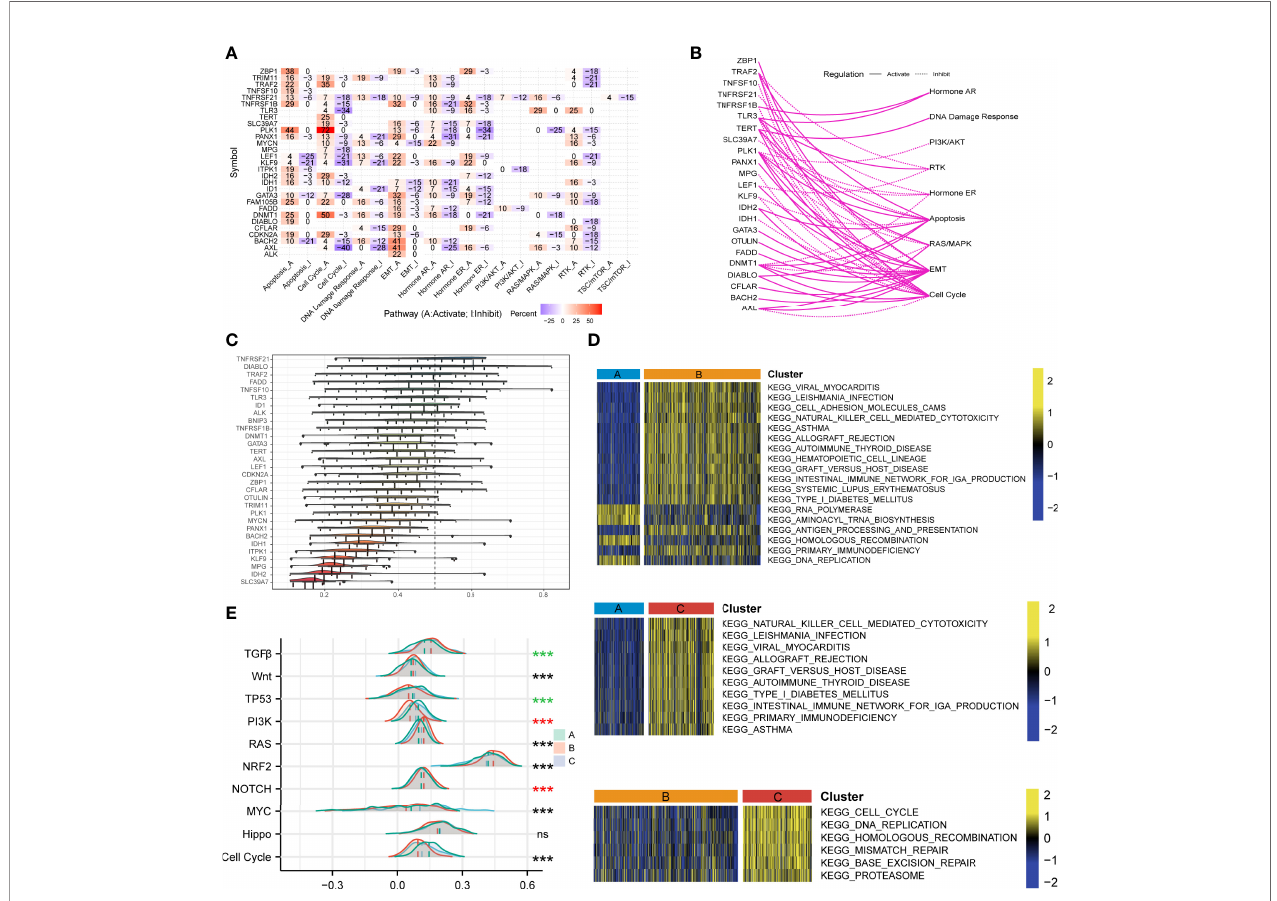
FIGURE 5 | Investigations of necroptosis- and cancer-related signaling pathways. (A) The heatmap illustrated the correlations between the mRNA expressions of the 29 necroptosis molecules in universally recognized cancer-related signaling pathways. Only a function (inhibited or activated) in at least 5 cancer types was displayed. “ Pathway activate ” in red represented the percentage of cancers where a pathway might be activated by the necroptosis regulators, and inhibition in a similar way illustrated as “ Pathway inhibit ” in blue. (B) The network showed the relationship between necroptosis regulatory genes by a line connection. The solid line meant activation, while dashed lines meant inhibition. (C) The distributions of functional similarities of the necroptosis-related molecules were summarized as complex boxplots. The boxes represent the middle 50% of the similarities, and the upper and bottom boundaries showed the 75th and 25th percentile. The lines in the boxes indicated the median values of the functional similarities. The continuous distribution was shown as the lines on boxes. The dots represented raw data. (D) Gene set variation analysis enrichment demonstrated the activated and inhibited states of biological pathways in distinct necroptosis regulatory phenotypes. The heatmap was employed to visualize the activity of biological pathways. Yellow represented activated pathways, and blue represented inhibited pathways. (E) The mountain graph showed the ten vital well-known cancerous signaling pathways among the three necroptosis clustering subtypes. Asterisks denoted p-value (***p < 0.001 and ns was the abbreviation of no signi fi cance), the color of which represented different statistical test methods. Black indicated Kruskal-Wallis test; red indicated one-way ANOVA test, and green indicated Welch one-way ANOVA